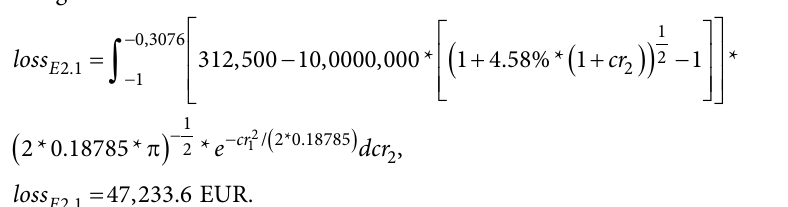
Table 7. Calculation of the expected interest income loss at Date 2 Expected loss in Remaining time to Corresponding Discount Present value coupon payments achieve the loss (in discount rate factor (in EUR) (in EUR) days) (in per cent) 1st coupon 47,233.6 732 4.76 0.9110 43,030.8 (02/01/2023) 2nd coupon 47,233.6 913 (02/07/2023)